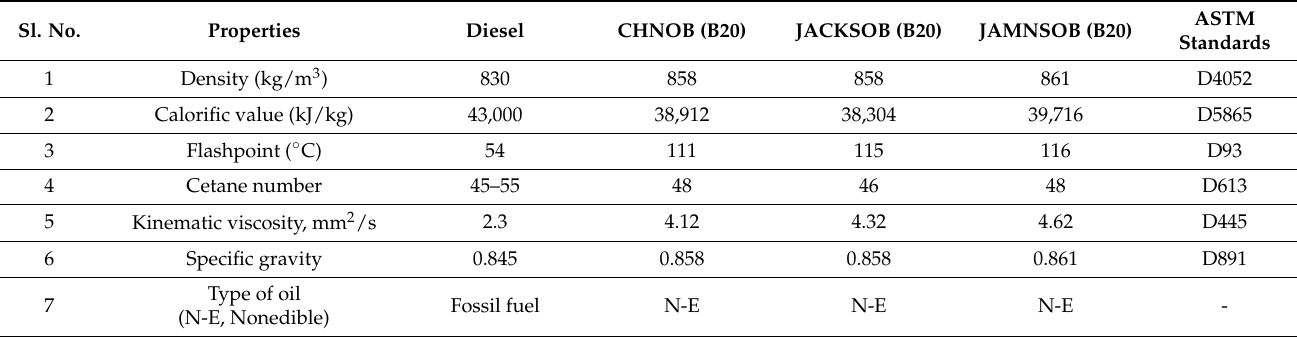
Table 3. Properties of diesel, CHNOB (B20), JAMNSOB (B20), and JACKSOB B20 [42]. Sl.